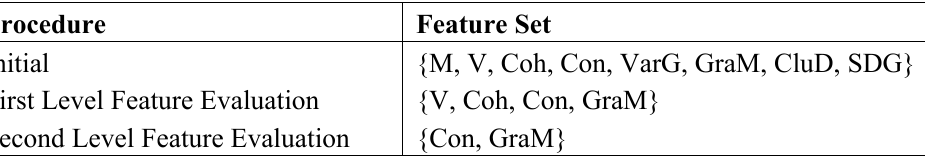
Table 4. Feature evaluation procedure and